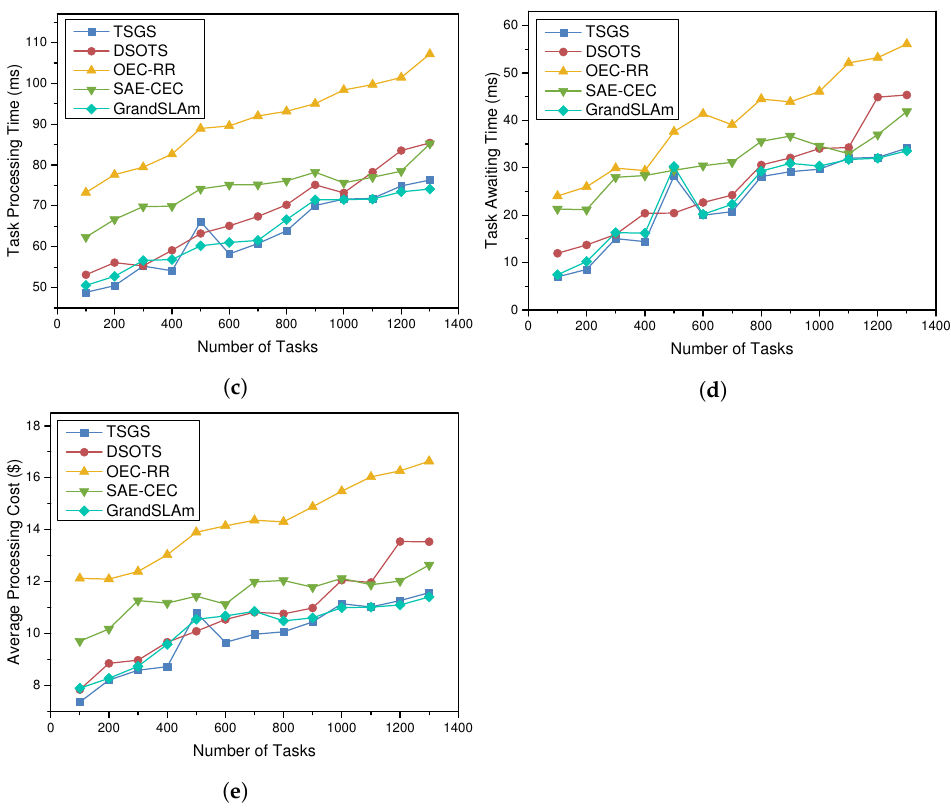
Figure 4. The impact of task number on SLA violation rate, time, and cost. ( a ) SLA violation rate; ( b ) SLA violation rate (DSOTS vs. TSGS vs. GrandSLAm); ( c ) task processing time; ( d ) task waiting delay; and ( e ) task processing